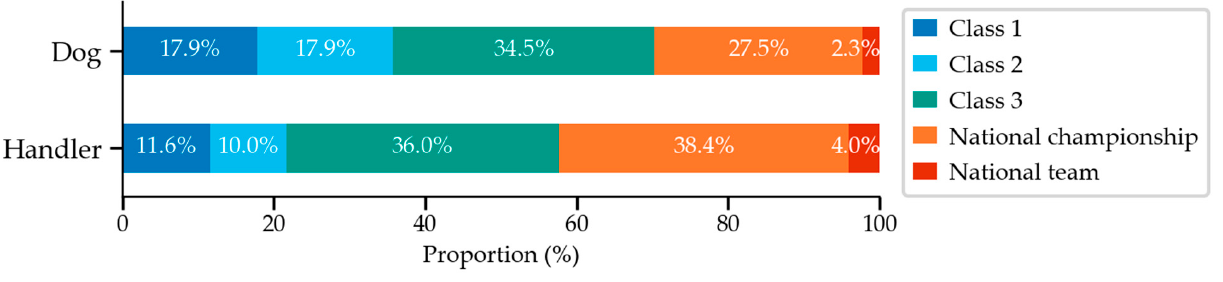
Figure 3. ( A ) Frequency of training sessions during winter ( n = 734) and summer ( n = 703) seasons. ( B ) Training session duration during winter ( n = 733) and summer ( n = 702) seasons. Error bars are used to indicate 95% confidence intervals. The frequency of training sessions or training session durations did not significantly differ between the winter and summer seasons. Weekly total training time was 18 min/week (13–25 min/week; n = 730). Only 0.5% of dogs trained for more than two hours a week. A dog’s highest competition level was as- sociated with weekly total training time ( p < 0.001, n = 730); dogs that had been part of the national team trained a median of 10 min/week, which was less than class 1 dogs ( p = 0.001; median 25 min/week), class 2 dogs ( p = 0.012; median 19 min/week), and dogs that had participated in national championships ( p = 0.043; median 18 min/week). Addition- ally, class 3 dogs, training a median of 18 min/week, trained less than class 1 dogs ( p = 0.008). The relative fence height in training was 88% (76–96%, n = 744) of the dog’s height at withers. The height category of the dog had a significant association with relative fence height ( p < 0.001); relative fence height increased with the height of the dog (Figure 4). A dog’s highest competition level was associated with its relative jump height in training ( p = 0.001), with class 1 dogs (median 83%) jumping significantly lower fences than dogs that had participated in national championships ( p = 0.002; median 91%) or been part of the national team ( p = 0.050; median 90%).